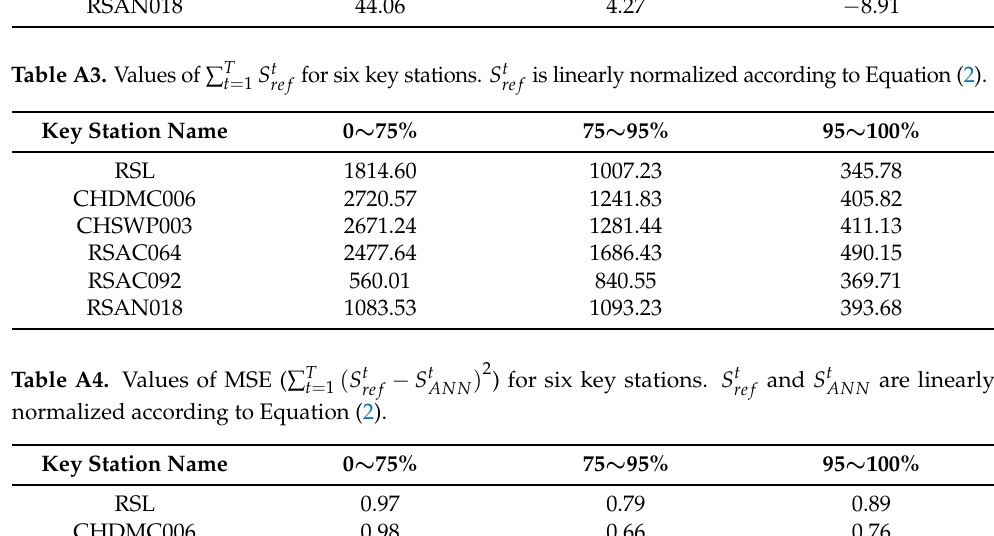
Table A3. Values of ∑ T